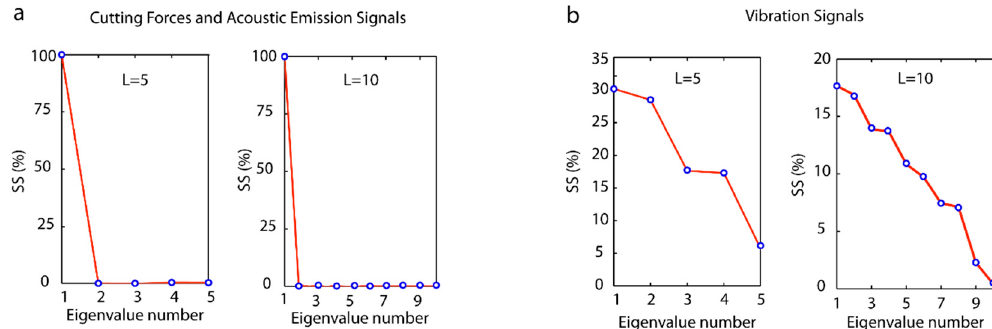
Figure 9. Signal analysis with the SSA method using two window lengths L = 5 and L = 10: ( a ) cutting forces and acoustic emission, and ( b ) vibration.